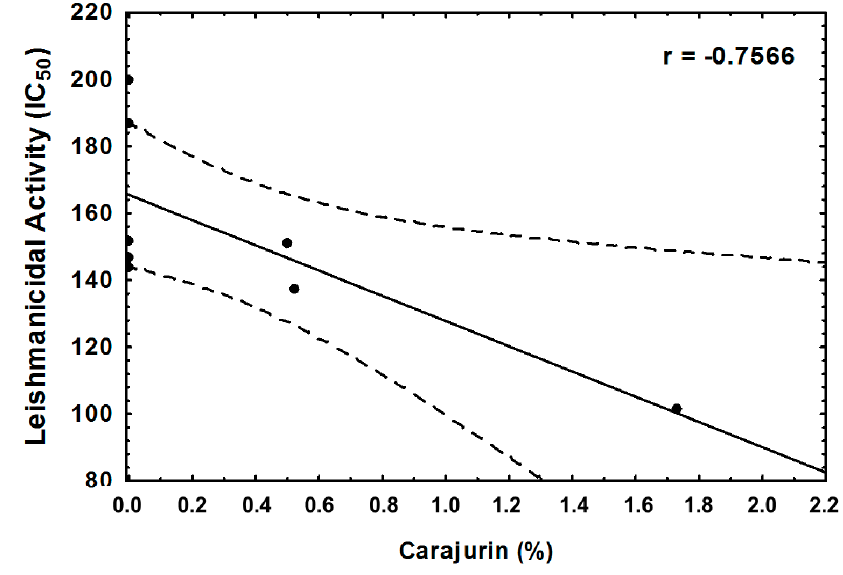
Figure 6. Correlation between carajurin obtained from Arrabideae chica and leishmanicidal activity against Leishmania amazonensis . r = − 0. 7566 and p = 0.030 by the Pearson’s correlation analysis.